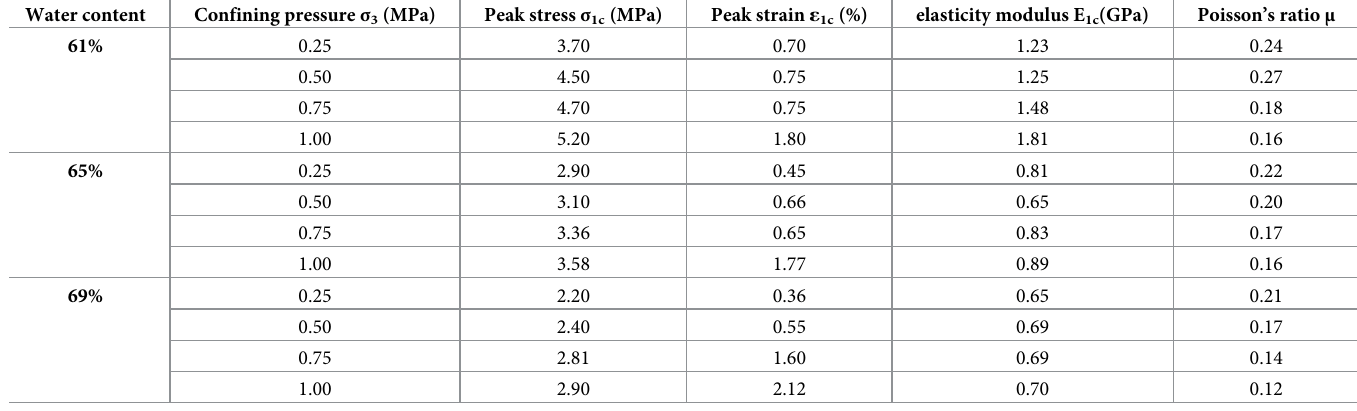
Table 2. Triaxial compressive strength and deformation